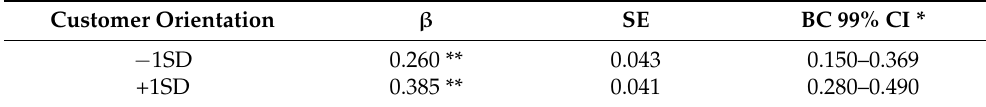
Table 11. Effect by customer